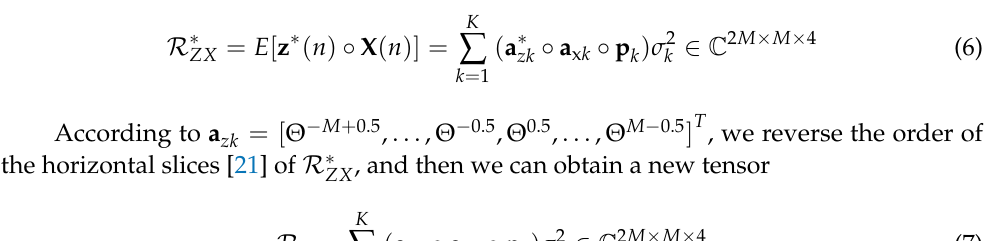
Figure 2. Virtual URA with Acoustic Vector Sensors.